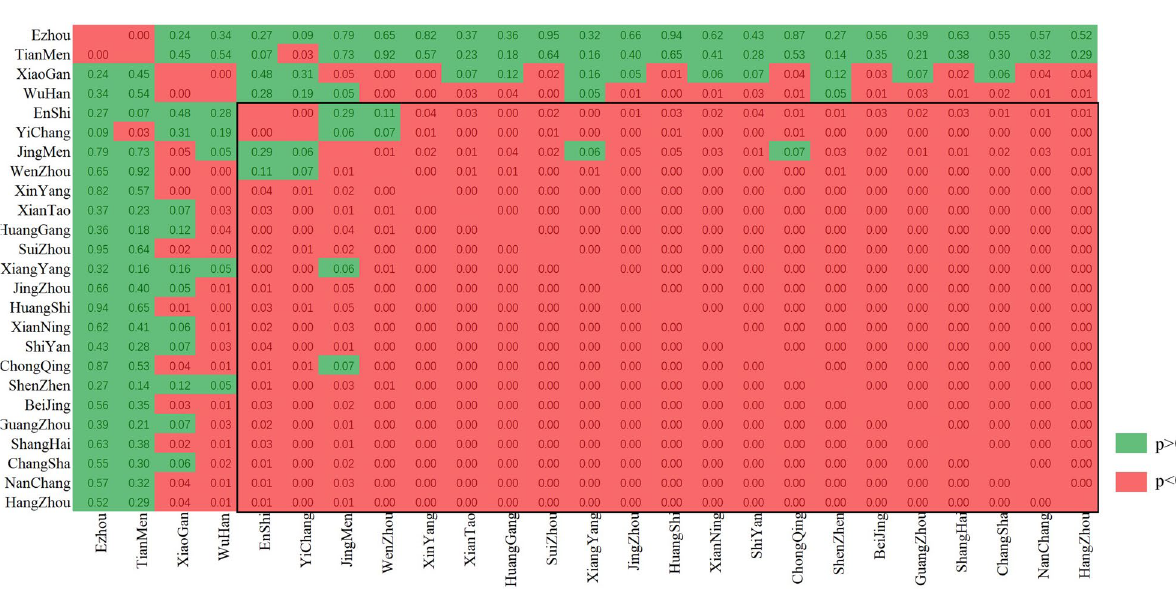
Figure 4. The p value of the correlation coefficient of the R time series among cities (if p < 0.05, the correlation is